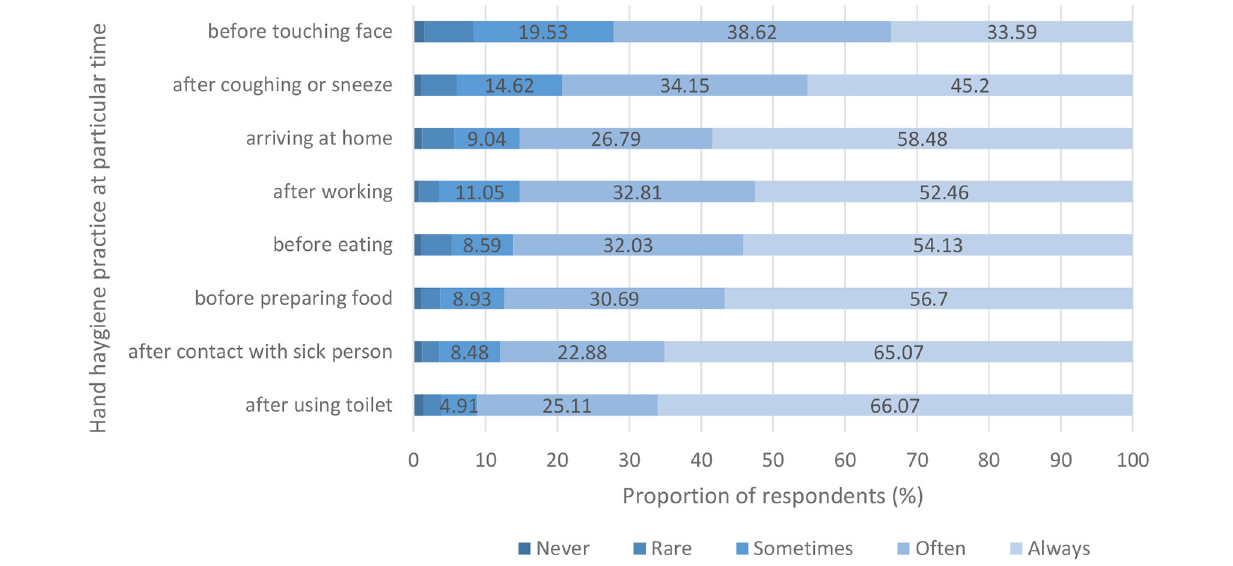
Frontiers in Public Health |